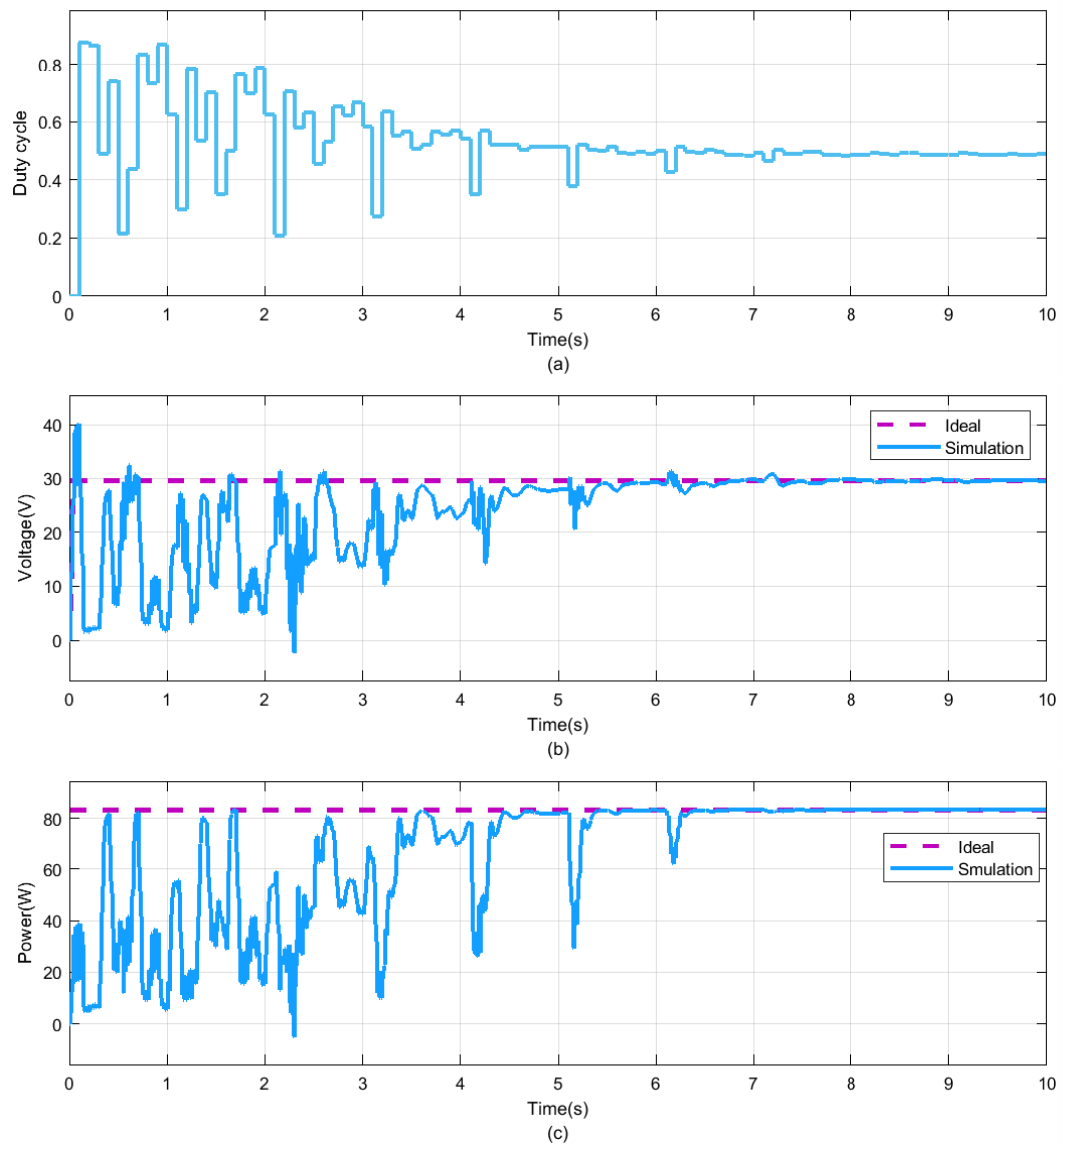
Figure 8. Simulation results under G = 800 W/m 2 , Tc = 48 ◦ C and Np = 10 given by the Improved Particle Swarm Optimisation (IPSO) algorithm: ( a ) Duty cycle, ( b ) Voltage, and ( c ) Power.